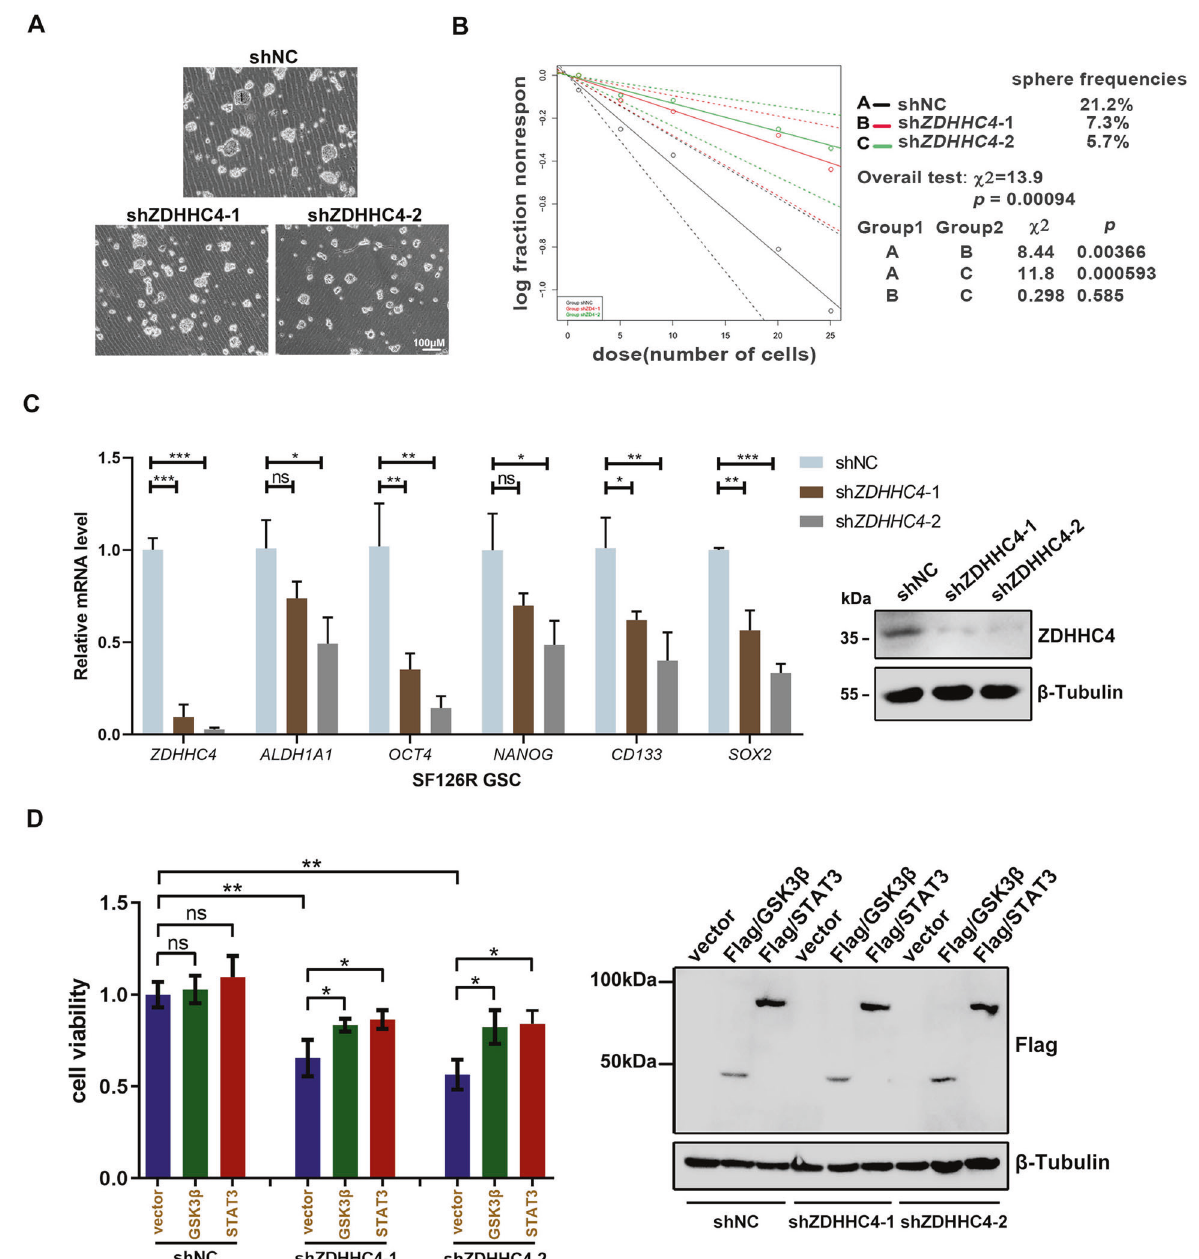
Fig. 4 GSK3 β palmitoylation contributes to the maintenance of stemness of TMZ-resistant GBM cells. A Representative images of GSCs induced from SF126R with ZDHHC4 knockdown. B Limiting dilution assay analysis (ELDA) of GSCs showed the frequencies of neurosphere formation. The signi fi cance of the difference between the indicated groups was determined by the χ 2 test ( n = 3 independent experiments). C Left, Real-time PCR analysis shows mRNA levels of STAT3 target stem-cell markers in ZDHHC4-knockdown SF126R GSCs. Control-shRNA cells were set to 1; right, Western blot veri fi es the effect of ZDHHC4 knockdown. D Left, SF126R cells with stable ZDHHC4 knockdown are supplemented with GSK3 β or STAT3 for 24 h. Cell viability is measured by CCK-8. The cells stably expressing shNC transfected with empty vector were set to 1; Right, Expression veri fi cation of GSK3 β and STAT3. Data are shown as means ± SD ( n = 3). P -values were determined by two-tailed Student ’ s t -test. * P < 0.05; ** P < 0.01; *** P < Next, we tested the tolerance of eight glioma cell lines to TMZ. was used to treat SF126 cells, inhibition of ZDHHC4 improved the SF126 had poor tolerance to TMZ and no MGMT expression, killing effect of TMZ on GBM (Fig. 3A, B). Combined with small- whereas U118MG and other cells had stronger resistance and molecule drugs in the STAT3 pathway, it was found that after higher MGMT expression (Supplementary Fig. 6A-B). The O-6- knocking out ZDHHC4, Colivelin, an agonist of STAT3, can inhibit methylguanine-DNA methyltransferase (MGMT) enzyme removes the killing ability of TMZ. Conversely, after overexpression of cytotoxic TMZ alkylation products from DNA and makes cells ZDHHC4, Stattic, an inhibitor of STAT3, enhanced the effect of TMZ resistant to TMZ [24]. SF126 and U118MG cells were treated with (Fig. 3B, C). These results showed that the regulation of TMZ TMZ into two TMZ-resistant cell lines, SF126R and U118R (R resistance in GBM by ZDHHC4 is mediated by STAT3.